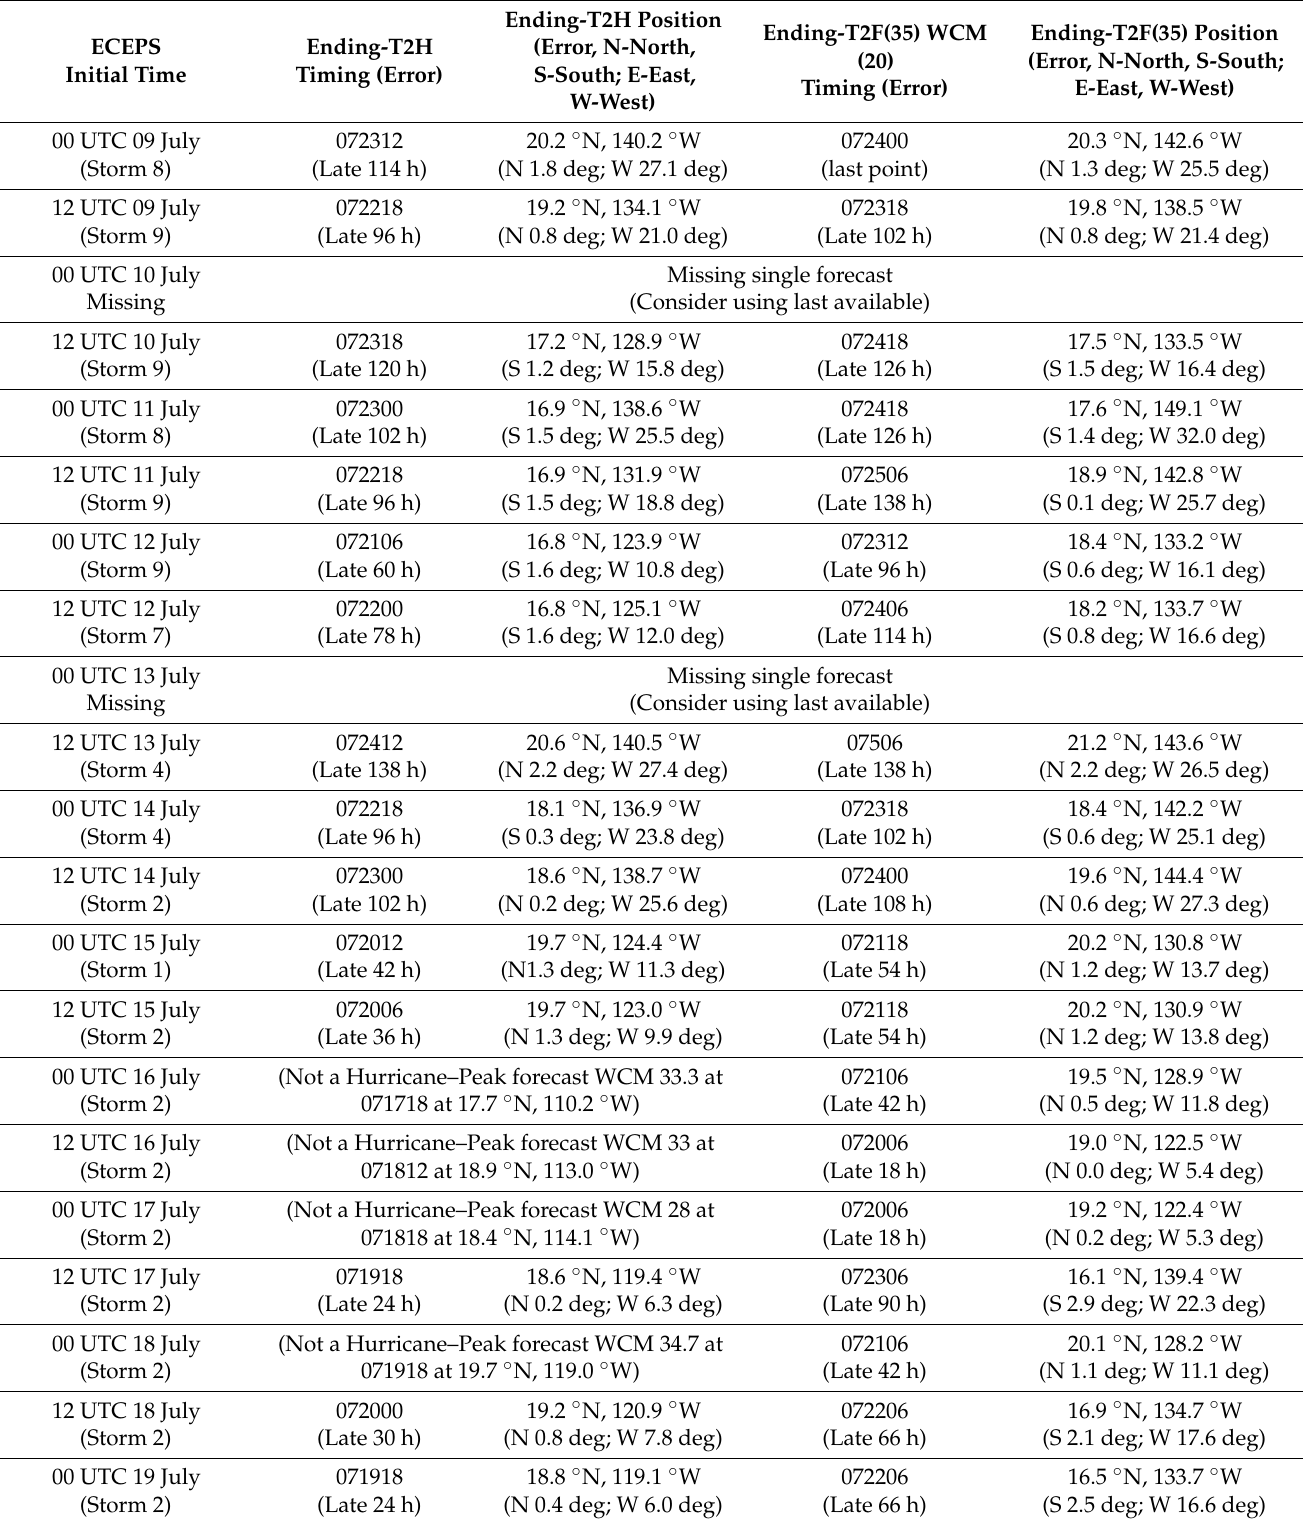
Table 4. ECEPS Timing and Position Predictions of T2F(35) and T2H during ending-Guillermo